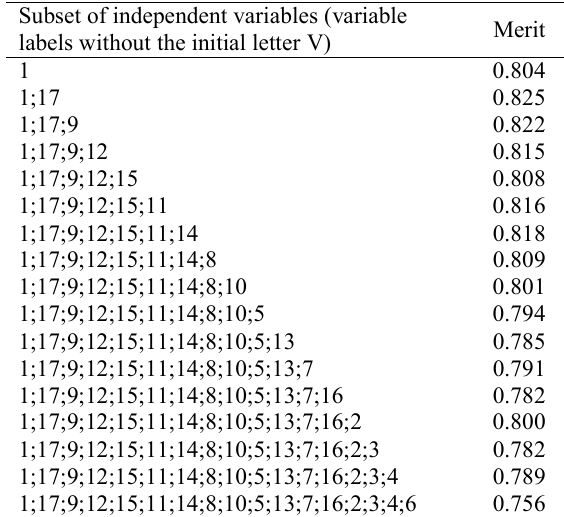
Table 4. Merit values for each subset of variables on the J-D trunk road section.